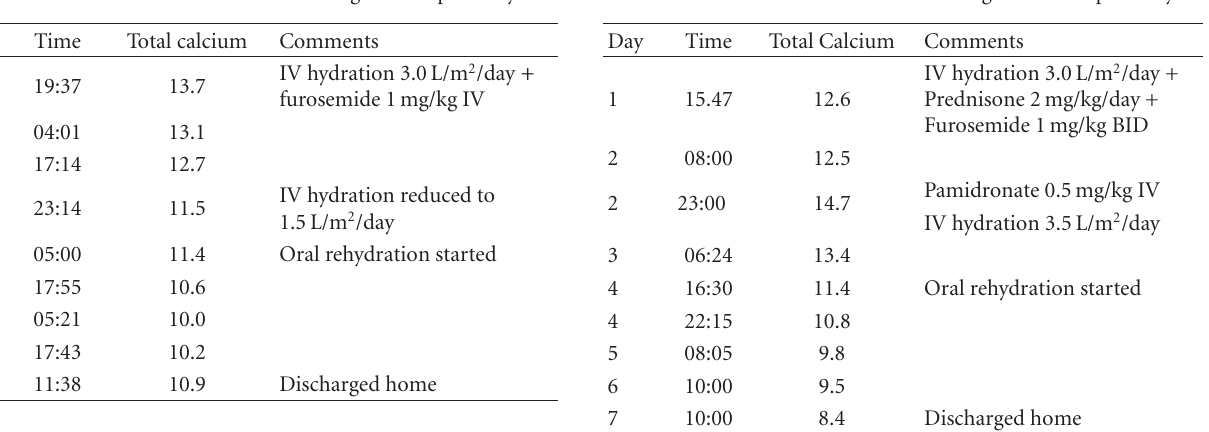
Table 1: Course of calcium levels during first hospital stay. Table 2: Course of calcium levels during second hospital